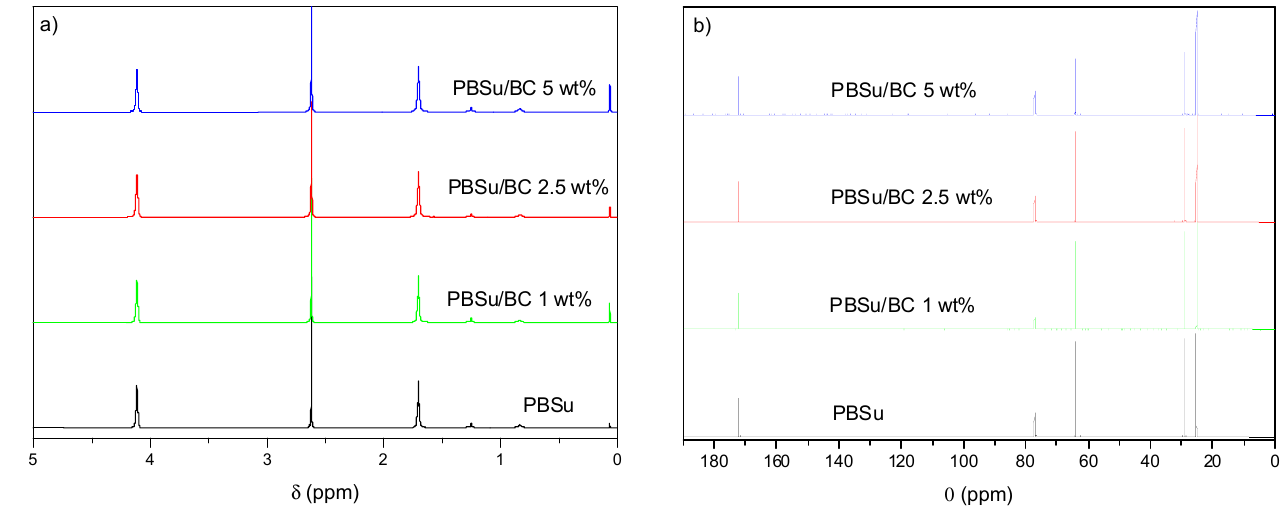
Figure 2. ( a ) 1 H NMR and ( b ) 13 C NMR spectra of the prepared biocomposites.